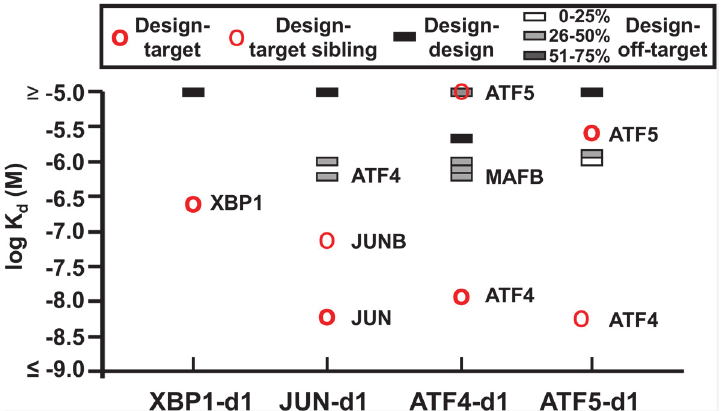
Fig 3. Specificity profiles of four designs tested at 37°C. The designed binders interact strongly with their targets as rhodamine-labeled peptides (bold red circles). Thin red circles show interactions with other bZIPs in the same family as the target. The ATF5-d1 design bound more tightly to ATF4 (thin red circle) than to ATF5. The designed proteins do not form strong homodimers (black bars), and there are large specificity gaps between the design/target interactions and design/off-target interactions (white and grey bars, colored according to target-off-target sequence identity at a , d , e and g positions). All K d values are listed in S5 – S12